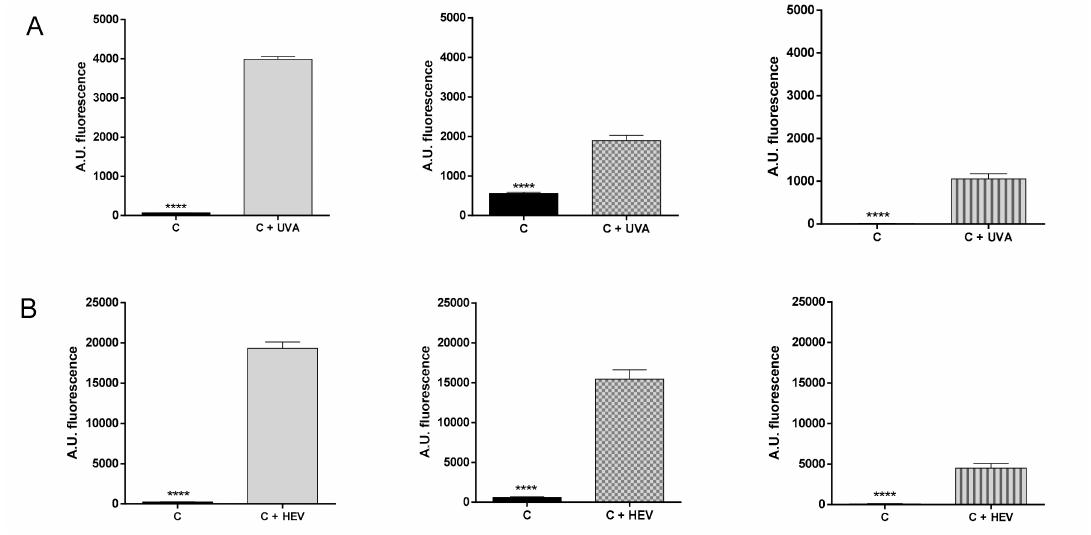
Figure 2. Barr graph showing ROS levels generated for HaCat culture cells (grey bar), RHE (grey bar with squares), and medaka embryos (grey bar with lines) after UVA radiation ( A ) and HEV radiation ( B ). C—control samples, C + UVA—control samples irradiated with UVA and C + HEV—control samples irradiated with HEV. **** p <